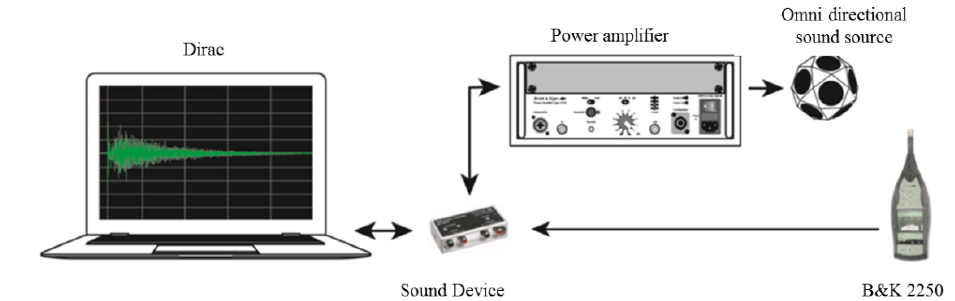
Figure 16. The system of the field measurement.